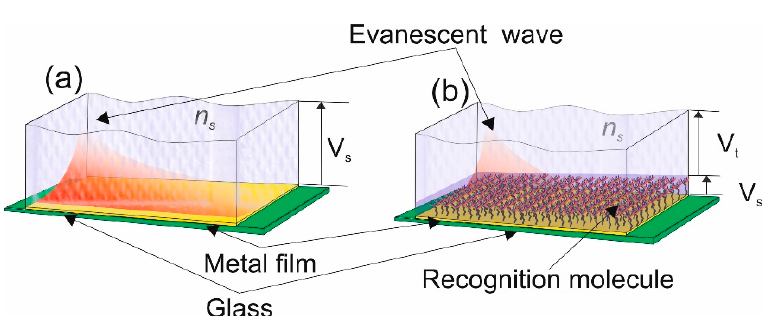
Sensors 2019 , 19 , x FOR PEER REVIEW